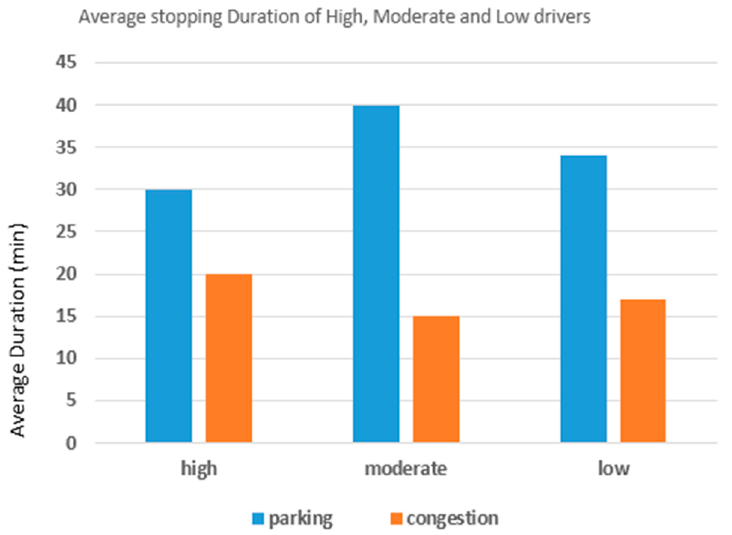
Figure 10. Average stopping duration of off-peak of high, moderate and low profitability drivers.